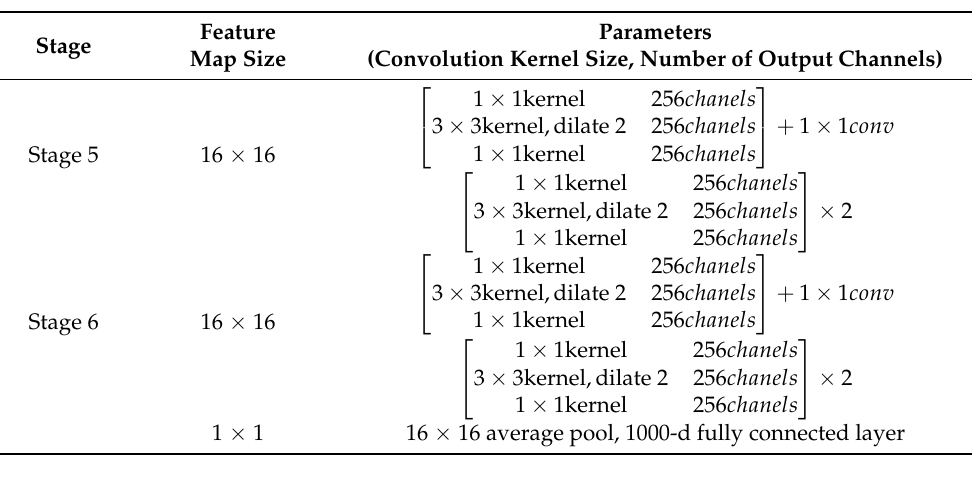
Table 1. The parameters of last two stages